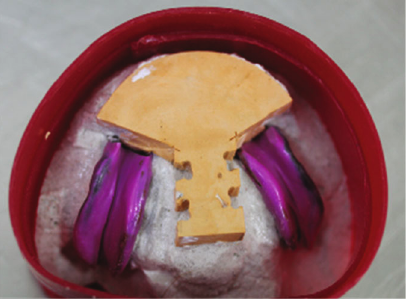
Figure 20: Boxing the impression. Figure 21: Altered cast.